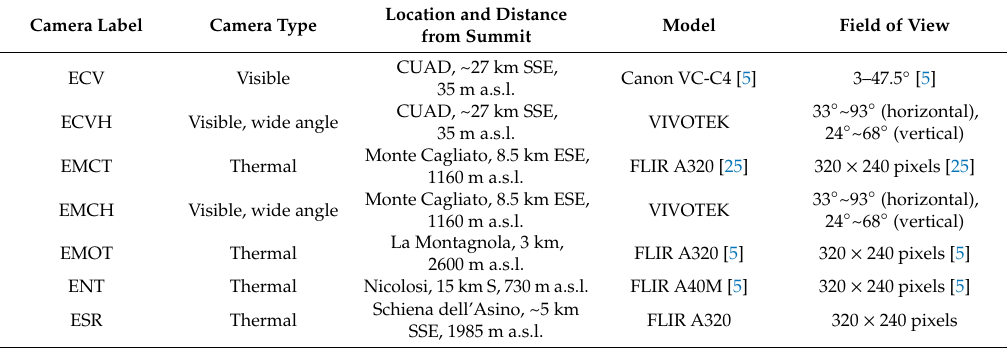
Table 1. List of the fixed monitoring cameras used in this study and comprising the Istituto